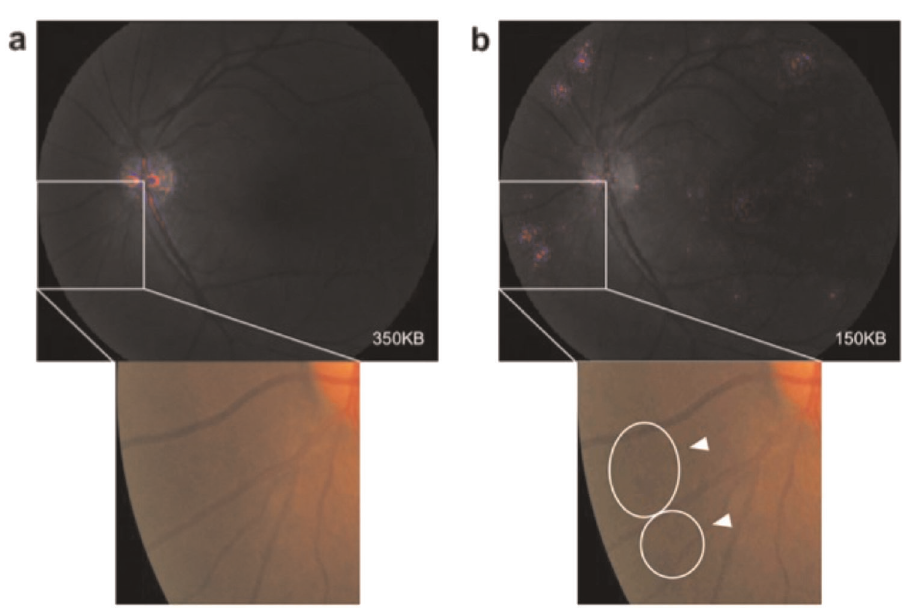
Fig. 3 Heatmaps generated for compressed images. Heatmaps showing the ‘ hot ’ areas that the DL algorithm focuses its attention on when making a diagnostic assessment on the retinal image. This was created using the Integrated Gradient method 66 . The colors on the greyscale retina image show the region of interest, with the red showing peak areas of region of interest while the blue shows the background areas of the region of interest. The white box isolates an area of the image to illustrate the difference between images of 350 and 150 KB in size. a A fundus photo of a healthy retina that was provided to the DL model as a 350 KB image. This was correctly classi fi ed by the DL model as a healthy retina with no DR. The heatmaps show focus on the normal optic disc and vasculature. b The same healthy retina is shown but compressed into a 150 KB size. This was misclassi fi ed by the DL algorithm as a retina with referable DR. The heatmaps show other regions of interest aside from the normal optic disc. The magni fi cation of one of these anomalous regions of interest depicts pixelations as identi fi ed by the white arrows and ovals. These pixelations amalgamate into a mistaken pathological manifestation of DR, resulting in its false positive